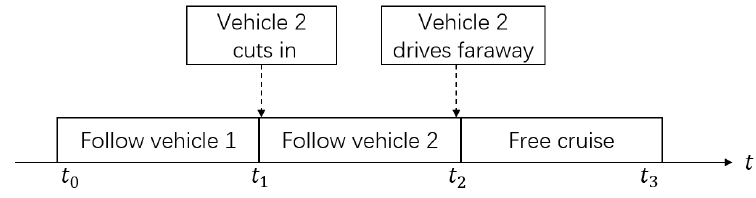
Figure 1. Car following process